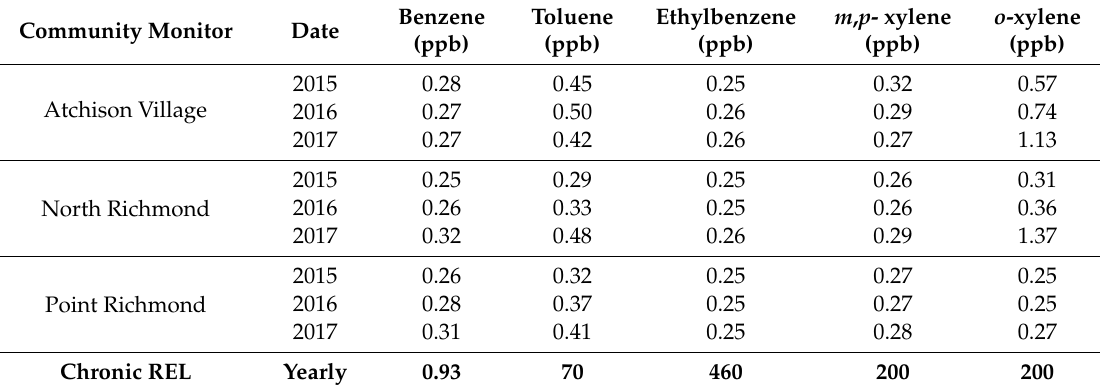
Table 1. Annual average concentration of BTEX at the three monitoring sites, and comparison with OEHHA chronic (i.e., annual average) threshold values. Non-detect data (below GC detection limit-0.5 ppb) were replaced with one-half the detection limit (0.25